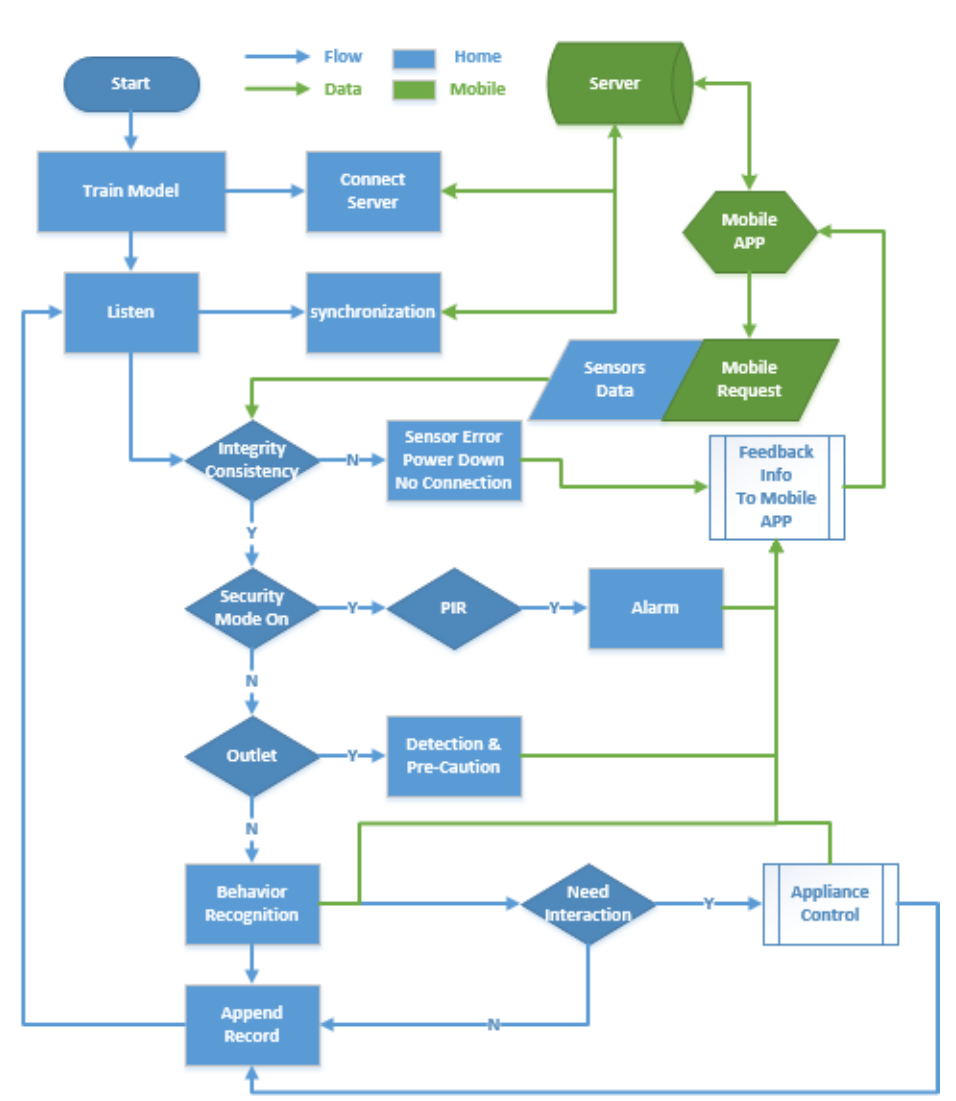
Figure 15. Detailed feedback control flowchart of sensing home.